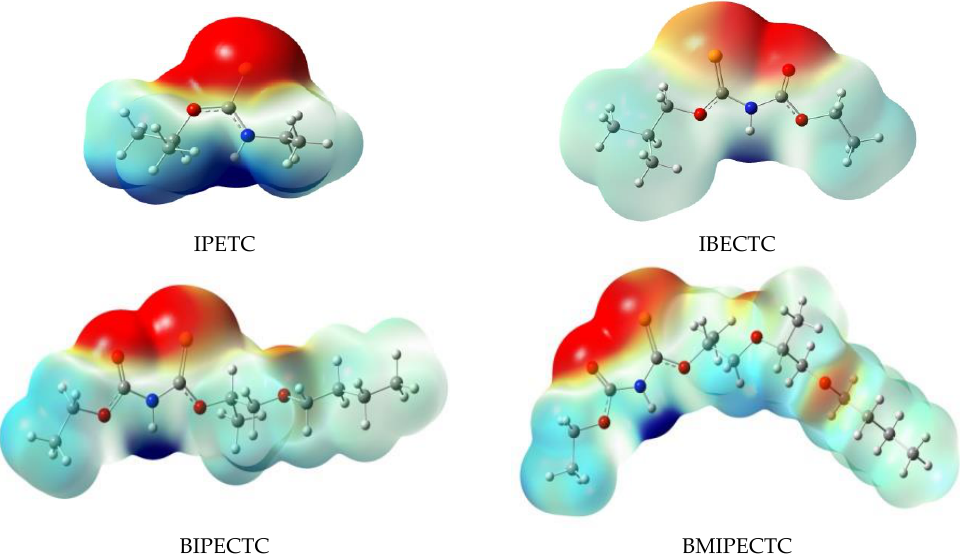
Figure 13. MEP maps for IPETC, IBECTC, BIPECTC and BMIPECTC.